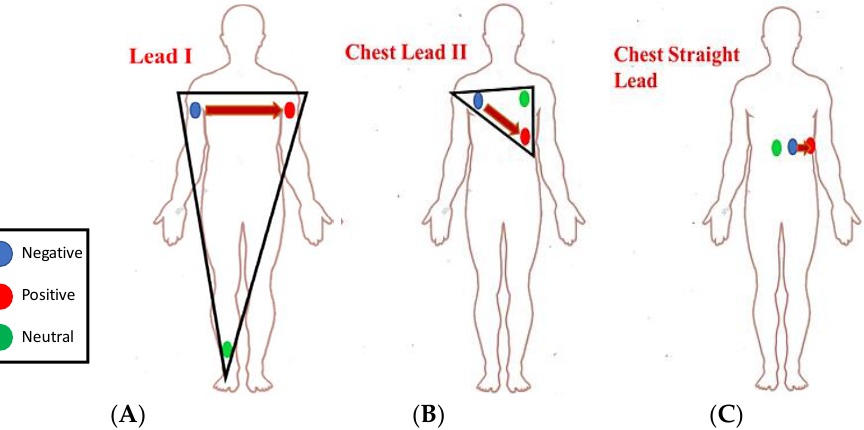
Figure 5. Different ECG lead configurations tested: ( A ) Lead I; ( B ) Chest Lead II; ( C ) Chest Straight Lead.